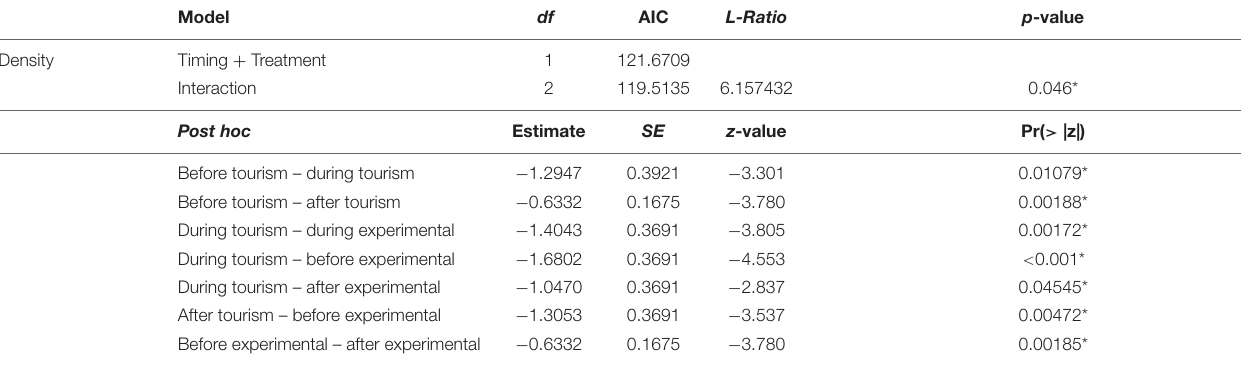
TABLE 2 | Statistical outputs of mixed-effects models accounting for the temporal correlation among site observations and Tukey’s post hoc test results for each research question and according